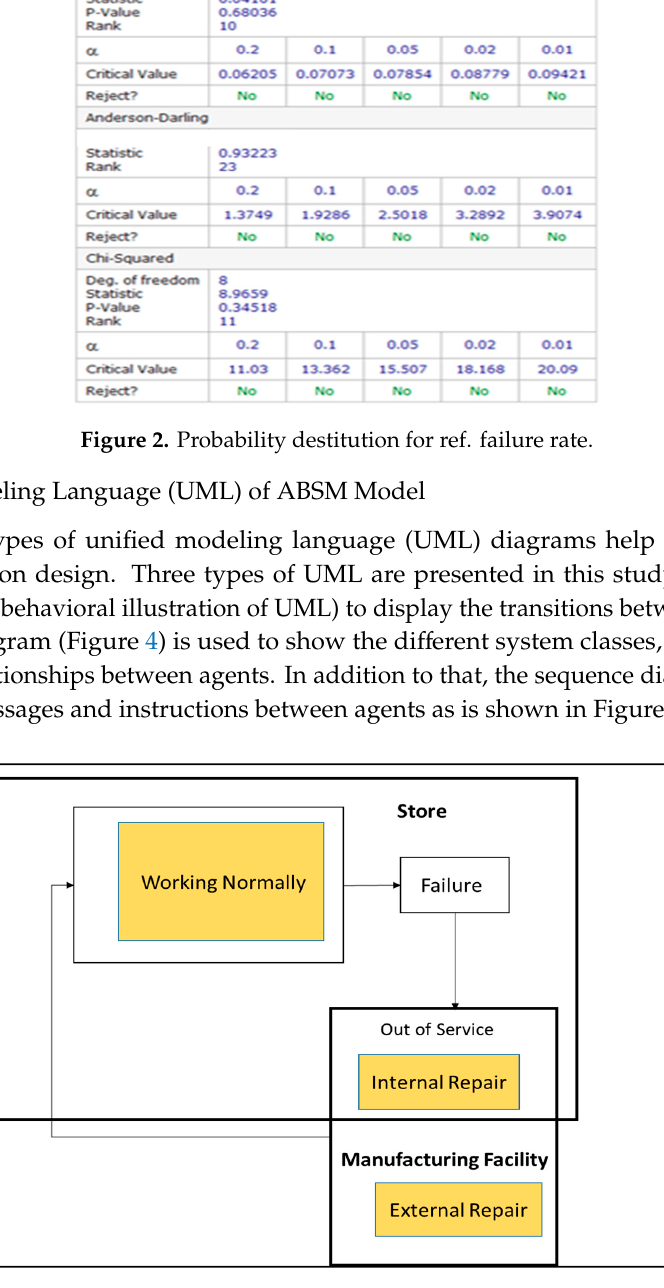
Figure 3. Statechart diagram.